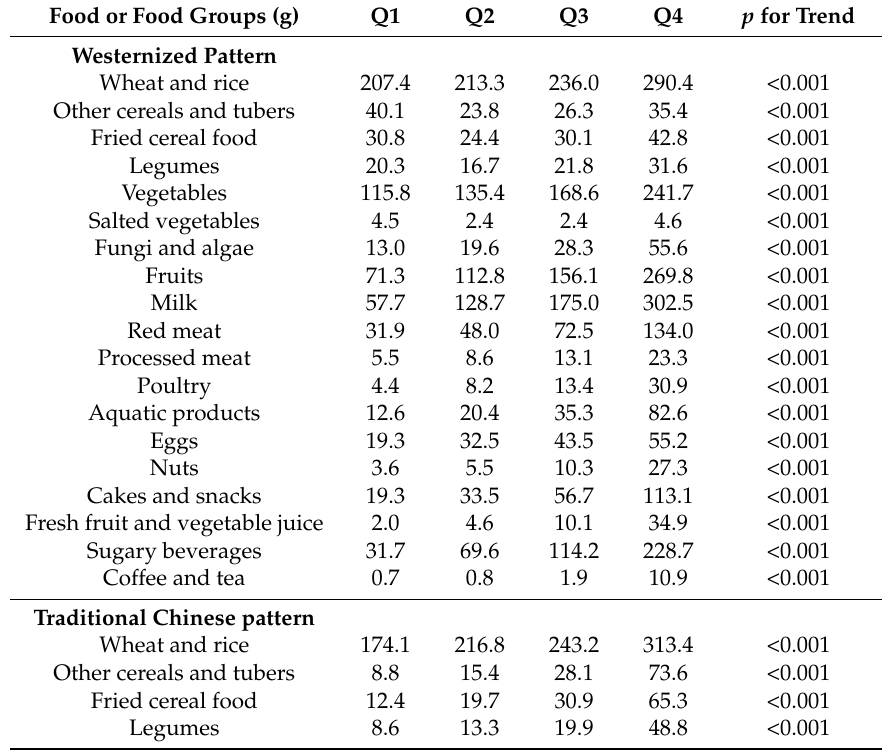
Table A2. Food intakes across the quartiles of two dietary patterns in Chinese children